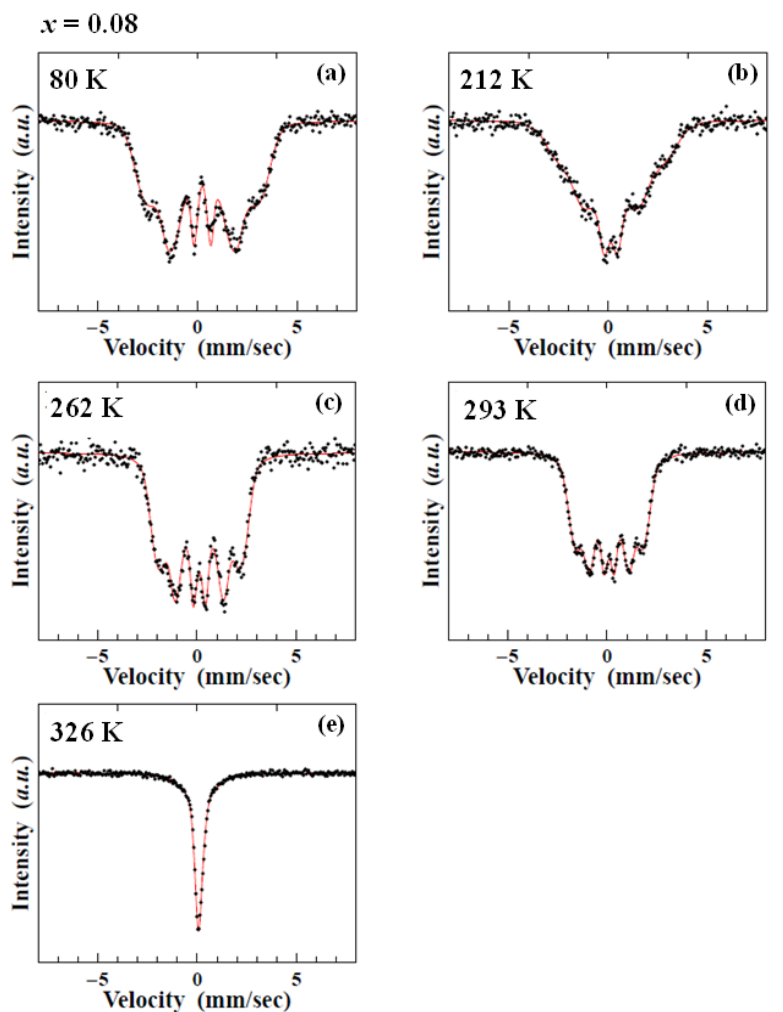
Figure 5. 57 Fe Mössbauer spectra and their fitting curves for x =